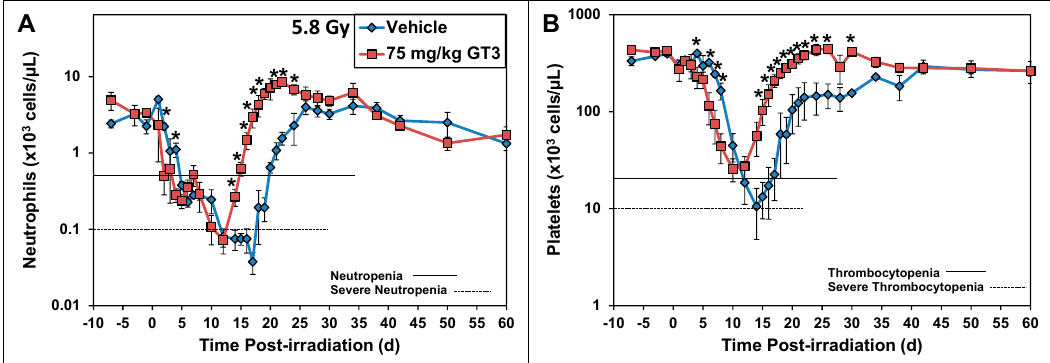
Figure 4. Effects of radiation exposure and GT3 treatment on the levels of neutrophils and platelets in peripheral blood of irradiated nonhuman primates (NHPs). Animal received GT3 (75 mg/kg, red) 24 h prior to irradiation. The vehicle control is colored blue. NHPs were irradiated with 5.8 Gy (0.6 Gy/min, cobalt-60 γ -radiation), and blood samples were collected at various time points in relation to irradiation. Neutrophils ( A ) and platelets ( B ) were analyzed with the Advia 120 cell analyzer. The mean and the standard error of the mean are displayed. The significant differences between GT3- and vehicle-treated groups are marked with * ( p < 0.05) [69].